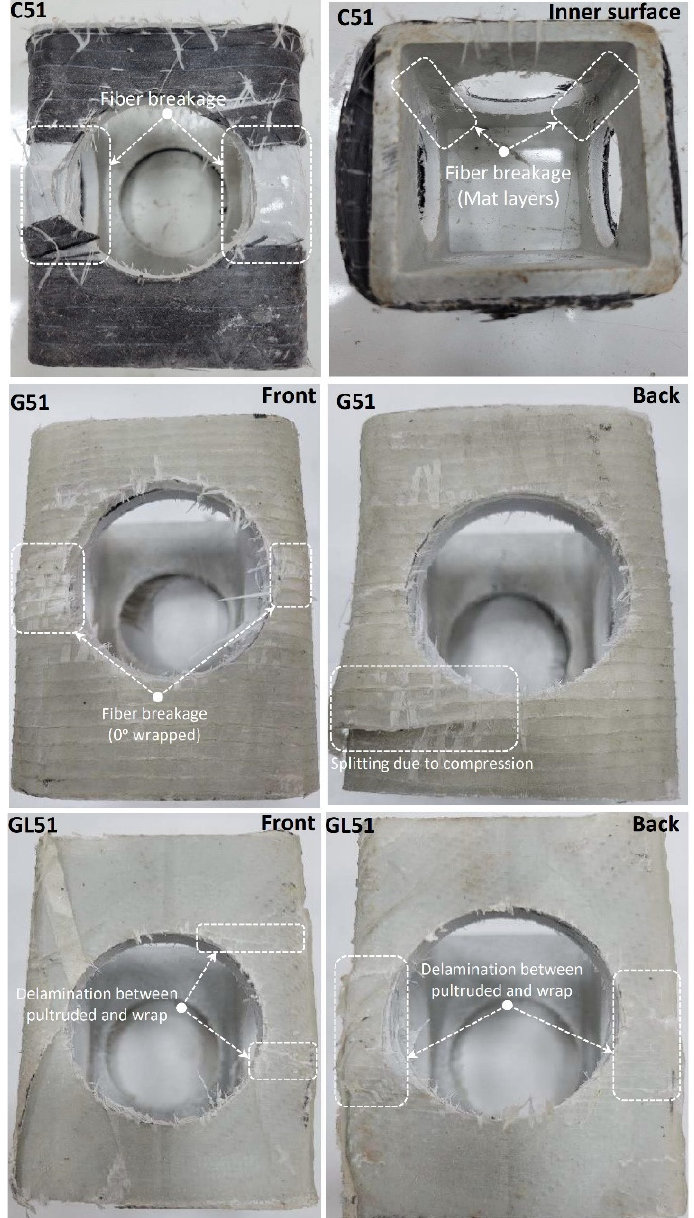
Figure 8. Damage analyses of C51, G51, and GL51.